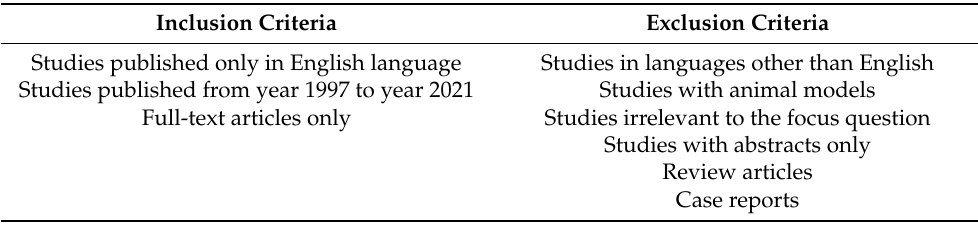
Table 1. Inclusion and exclusion